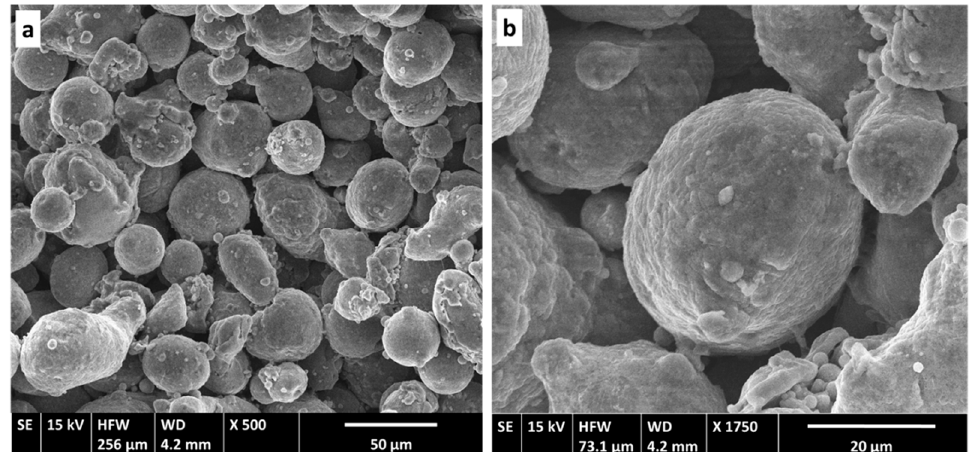
Figure 1. Secondary electron (SE) images of as-received atomized AA7075 powders: ( a ) morphology of the powders; ( b ) detailed image of the topology of the surface.